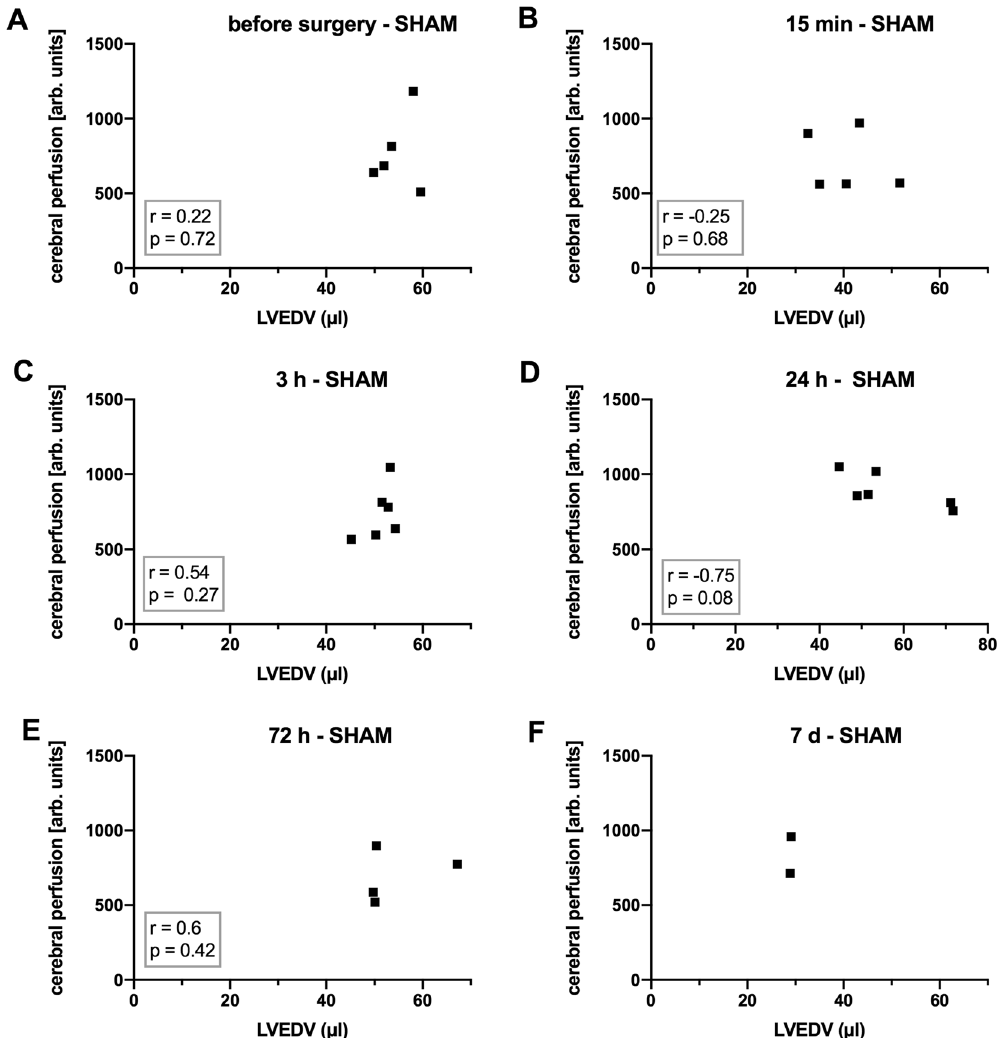
Figure 5. Correlations of LVEDV with cerebral perfusion in sham animals. ( A )–( E ) Correlations of left ventricular end-diastolic volume (LVEDV) with cerebral perfusion at the indicated times post-surgery. ( F ) For 7 days postop., a correlation analysis was not performed due to the case number. n = 5 for the time points before surgery and 15 min post-surgery; n = 6 for 3 h and 24 h postop.; n = 4 at 72 h and n = 2 at 7 days postop. Correlation is expressed by Pearson’s or Spearman’s correlation coefficient (r) as appropriate, with p < 0.05 considered statistically